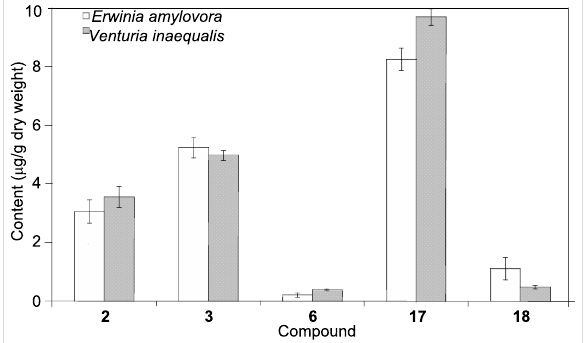
Figure 2: Biphenyl and dibenzofuran concentrations determined in S. aucuparia cell cultures after treatment with E. amylovora and V. inae- qualis [23]. Data are average values ± SD ( n = 3).